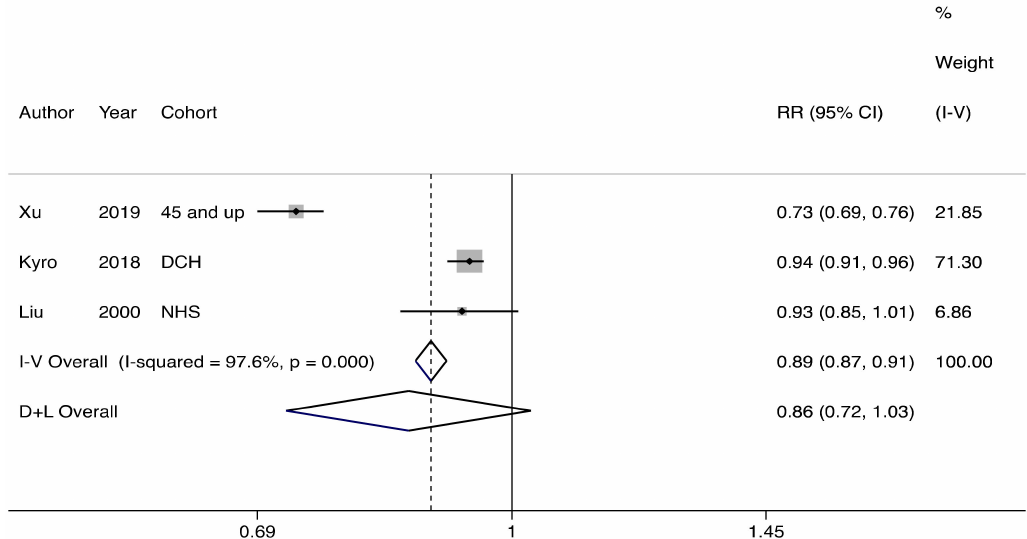
Figure 3. The association between oat consumption and risk of type 2 diabetes. Consumers vs. non-consumers are compared. I-V: inverse-variance estimation, random effect model. D + L: DerSimonian–Laird (DL) method, fixed effect model